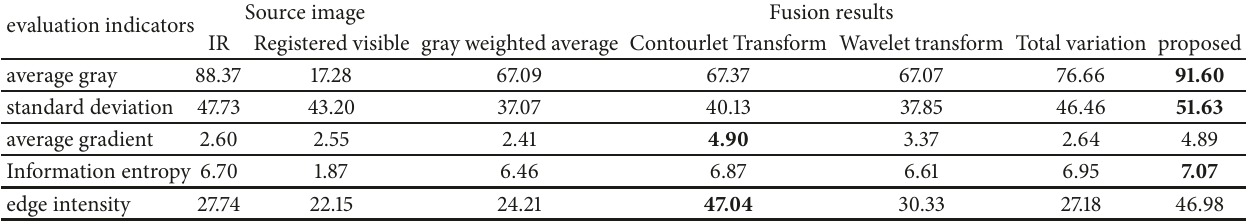
Table 2: Quantitative evaluation of source image and fusion results at daytime.